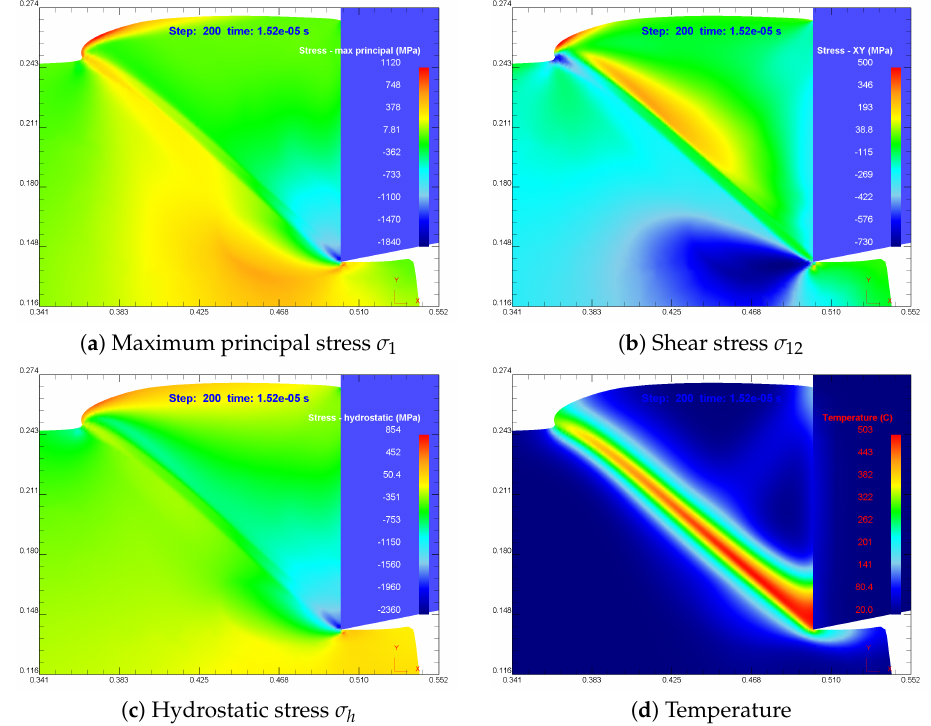
Figure 15. Distribution of the maximum principal stress σ 1 , shear stress σ 12 , hydrostatic stress σ h and temperature during the formation of an adiabatic shear band in thermally aided shear